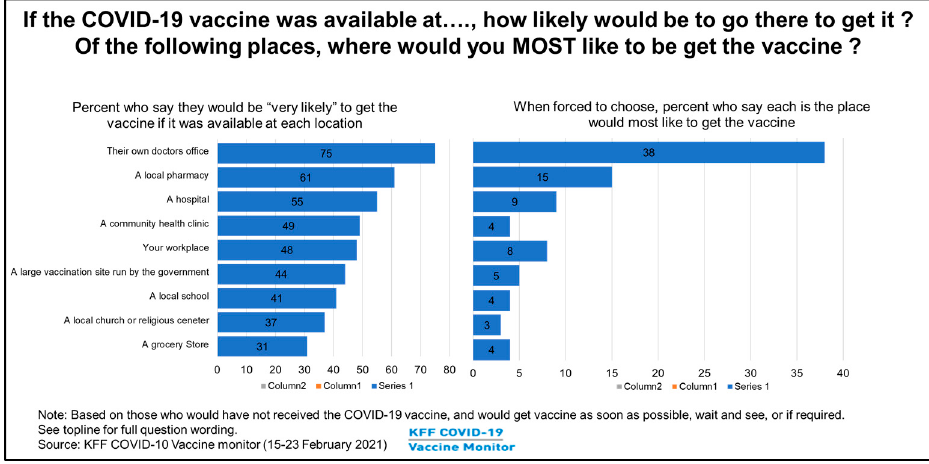
Figure 5. Vaccination location preferences of patients .